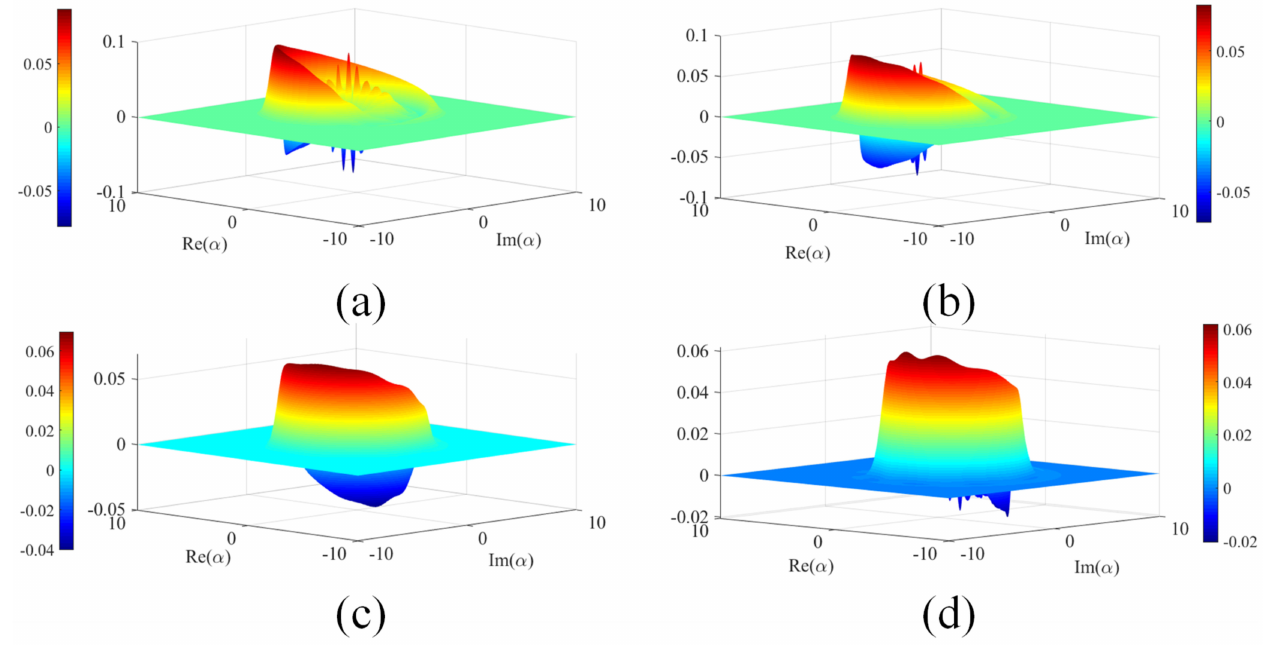
Figure 1. The Wigner function W ( α ) as a function of Re ( α ) and Im ( α ) , where α a = 4, α m = 2, K / ω = 0.005 and g = 10 K . ( a ) t = 65; ( b ) t = 70; ( c ) t = 75; ( d ) t =